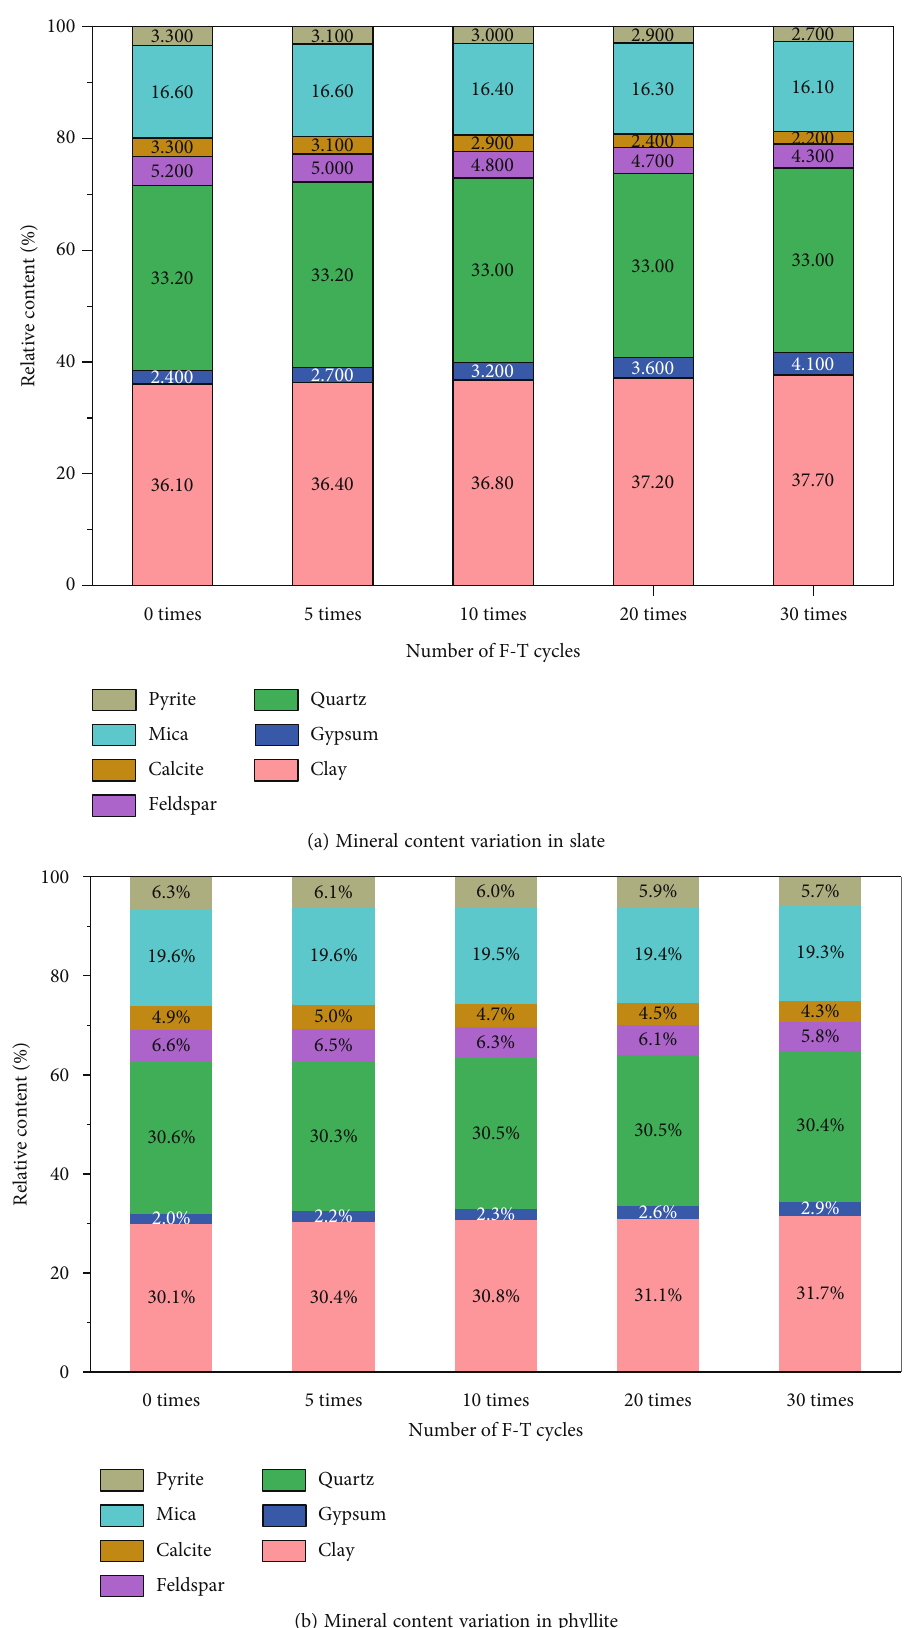
Figure 10: X-ray di ff raction (XRD) scans of two low-grade metamorphic rocks with increasing number of F-T